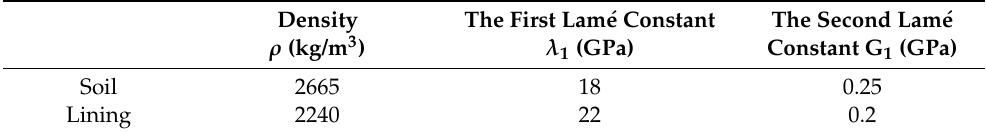
Figure 6. Amplification of radial displacement along the external tunnel surface: ( a ) P wave verti- cally incident and ( b ) SV wave vertically incident.